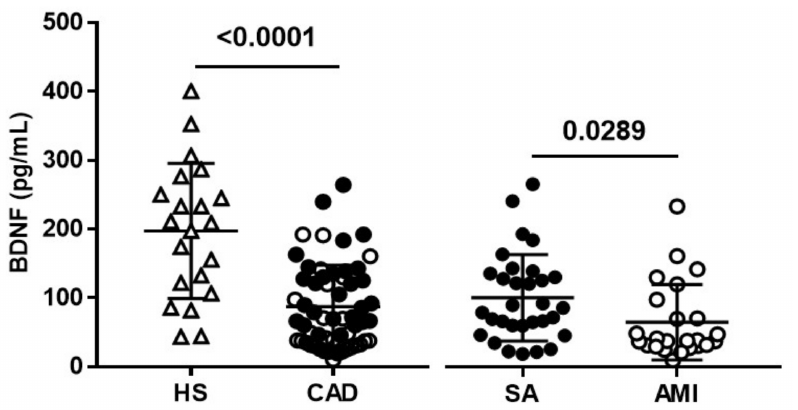
Figure 1. Plasma BDNF levels. BDNF was measured in healthy subjects (HS) and coronary artery disease (CAD) patients with diagnosis of stable angina (SA) and acute myocardial infarction (AMI). Data are expressed as mean ±